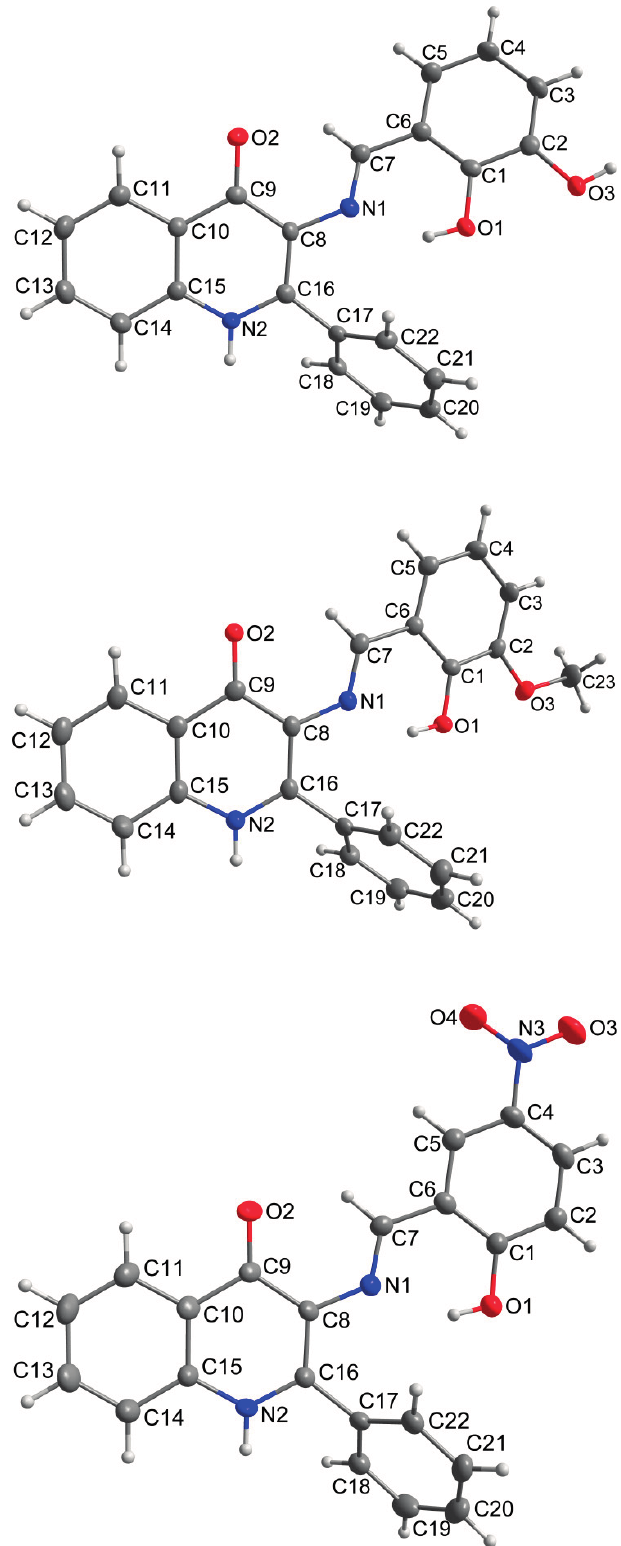
Figure 1. Molecular structures of compounds 1 (top), 3 (middle) and 7 (bottom) together with the atom numbering scheme. The water molecule of crystallization in compound 1 was omitted for clarity. The non-H atoms are drawn as thermal ellipsoids at the 50% probability